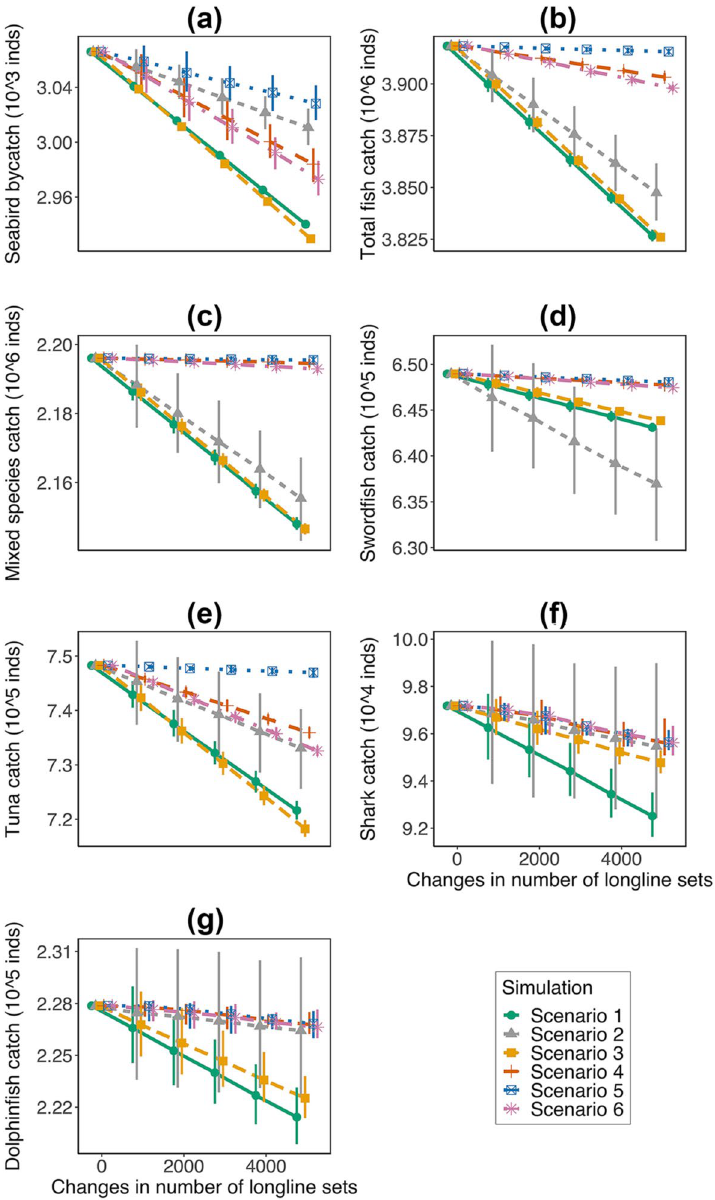
Figure 7. ( a ) Total number of bycatch estimates (individual birds) from 1992 to 2017, ( b ) total number of fish caught estimates (individual fish), ( c ) number of mixed species caught estimates (individual fish), ( d ) number of swordfish caught estimates (individual fish), ( e ) number of tuna caught estimates (individual fish), ( f ) number of pelagic sharks caught estimates (individual fish), ( g ) number of dolphinfish caught estimates (individual fish) under six scenarios of simulated change in fleet behavior. Point represents the mean value of the 1000 posterior means. Error bar represents the 95% credible interval. Plot is made using R package ggplot2 (version 3.3.2, https:// ggplo t2. tidyv erse. org) in statistical program R (version 3.6.3, http:// www.R- proje ct.